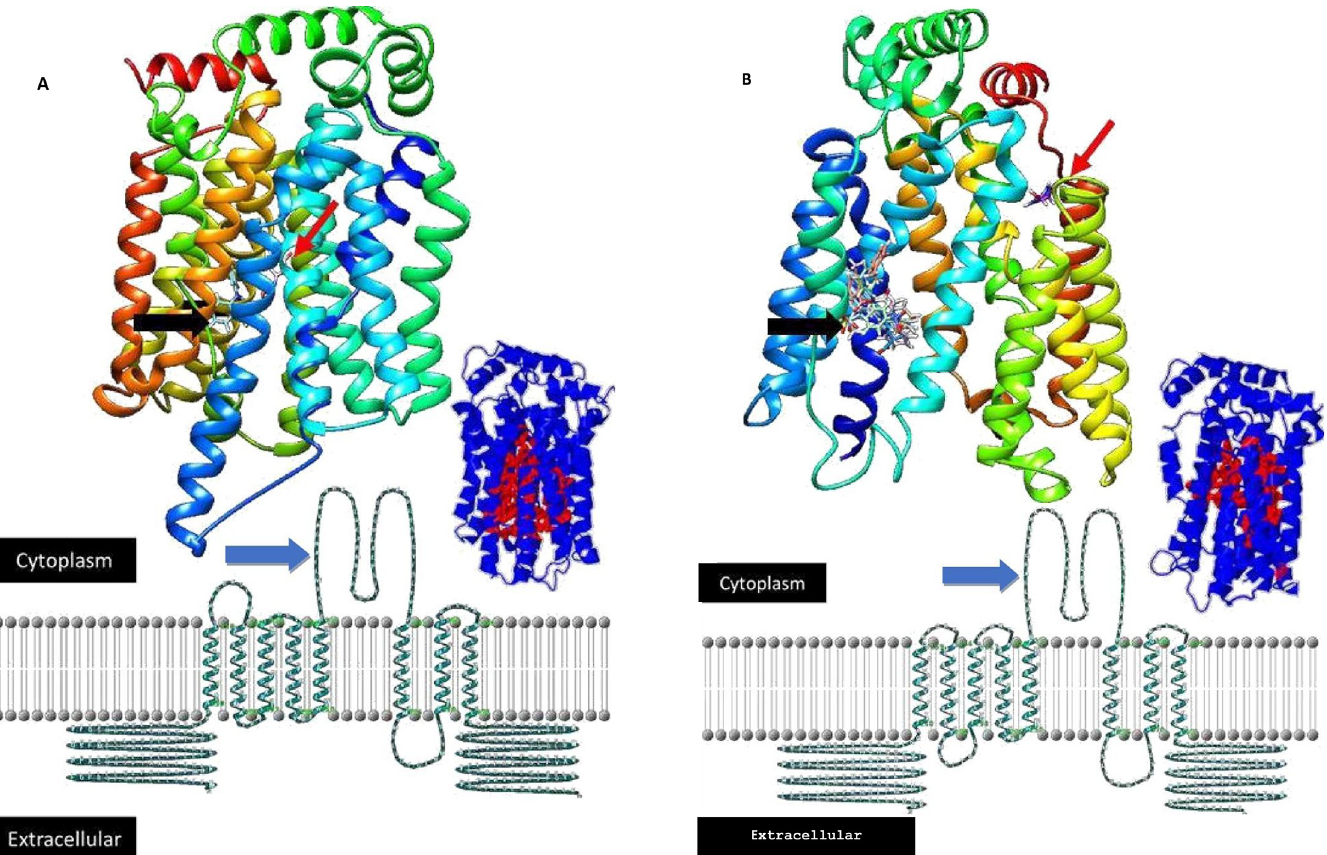
Fig 4. Predicted 3D and 2D organic anion transporter 2 (OAT2) from the chicken (A) and the African white-backed vulture (AWB) (B). The inserts are the identified major pocket (red). Black arrow is the predicted NSAID binding site(s), which is only diclofenac for the chicken and multiple NSAIDs for the vulture for which toxicity information is available. Red arrows are the predicted urate binding sites. Predicted Intracellular loop of chicken (C) and the AWB (D) organic anion transporter 2. Pictorial presentation of (E) AWB OAT1 representing 10 transmembrane helices and no N-glycan motif sites and the (F) AWB OAT2 representing 11 transmembrane helices and 5 N-glycan motif